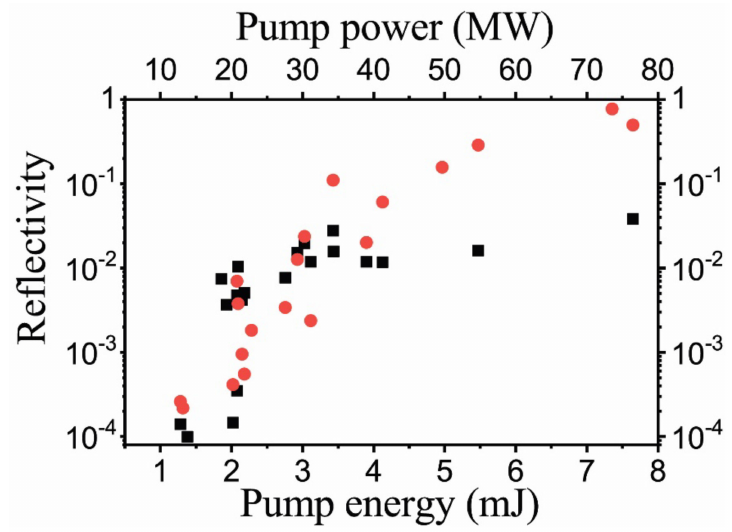
Figure 10. Reflectivity (signal-to-pump ratio of pulse energies) of ZnO nanoparticle solution in water vs. pump pulse energy measured for the Stokes shifted (red circles) and anti-Stokes shifted backscattered radiation (black squares) from 100 ps pump laser pulses.